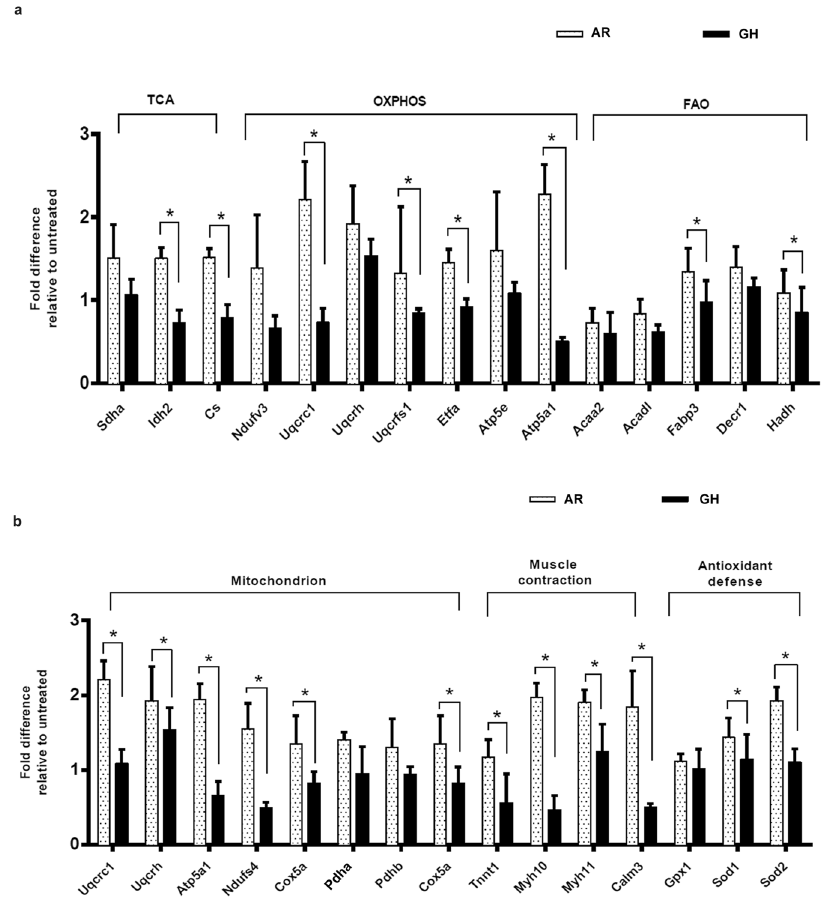
Figure 3. AR improved whole cardiometabolic profile suggests increased bioenergetics function in myocardium of aged rats. ( a ) LC-MS analysis suggests increased expression of proteins regulating the mitochondrial tricarboxylic acid cycle, oxidative phosphorylation (OXPHOS) and fatty acid oxidation pathways in heart tissues of AR administered rats. ( b ) A significant fold differences are seen in the expression of proteins regulating the mitochondrial OXPHOS, muscle contraction and antioxidant defense pathways. Sdha: Succinate dehydrogenase a, Idh2: Isocitrate dehydrogenase 2, Cs: Citrate synthase, Ndufv3: NADH dehydrogenase ubiquinone flavoprotein 3, Uqcrc1: Ubiquinone cytochrome b c1 complex subunit 1, Uqcrh: Ubiquinone cytochrome b c1 complex subunit 6, Uqcrfs1: Ubiquinone -cytochrome C reductase iron- sulfur subunit Etfa: Electron transfer flavoprotein alpha subunit, Atp5e: ATP synthase subunit epsilon, Atp5a1: ATP synthase subunit α , Acaa2: Acetyl-CoA acyltransferase 2, Acadl: Acyl-CoA dehydrogenase, Fabp3: fatty acid binding protein 3, Decr1: 2, 4 dienoyl CoA reductase, Hadh: Hydroxyacyl-CoA dehydrogenase, Ndufs4: NADH dehydrogenase [ubiquinone] iron-sulfur protein 4, Cox5a: Cytochrome C oxidase subunit 5A, Pdha/b: Pyruvate dehydrogenase A/B, Tnnt1: TroponinT, Myh10/11: Myosin heavy chain isoforms, Calm3: Calmodulin isofom 3, Gpx1: Glutathione peroxidase 1, Sod1/2: Superoxide dismutase type 1 or 2. Values represent the mean ± s.e.m. of data from 3 rats in each group. * P < 0.05 (AR versus GH, relative to control groups), these results were analyzed by 2-way ANOVA followed by multiple comparisons with Tukey’s